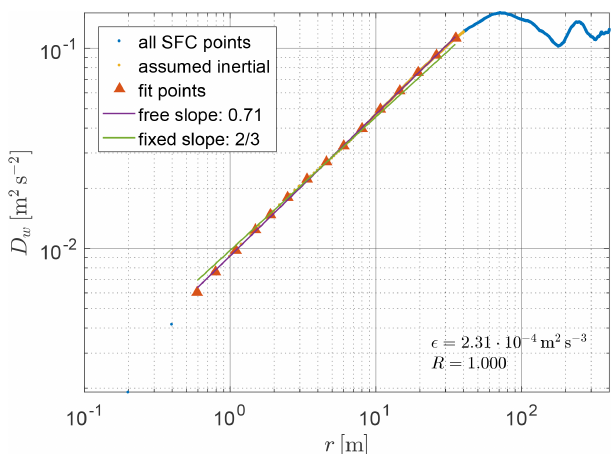
Figure 7. Example of (cid:15) derivation with structure function method (flight no. 5, LEG307, vertical component). Computed SFC (Eq. 11, blue) is resampled in the assumed inertial range (yellow) to obtain logarithmically spaced points (triangles) which are used for least- squares fits: one with free slope (Eq. 13, purple), one with fixed theoretical slope (Eq. 12, green).